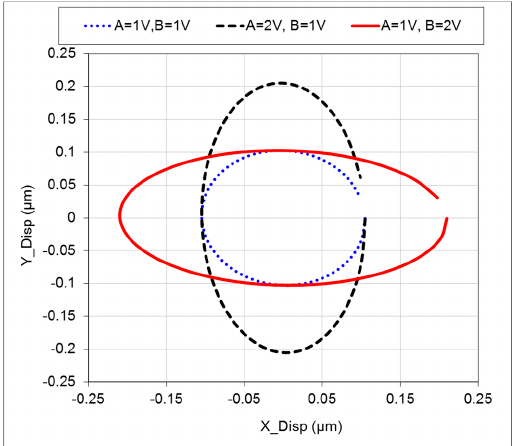
Figure 11. Calculated motion trajectories, when the magnitude of the signals applied on the top or on the bottom electrodes is changed.